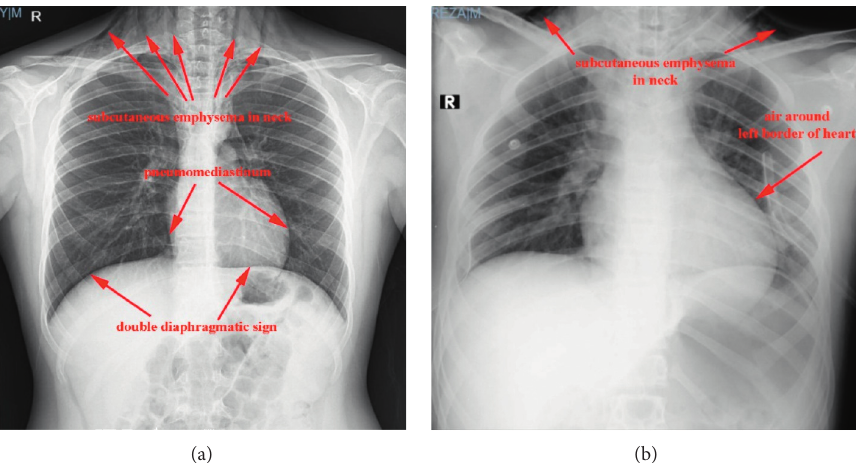
Figure 1: Chest X-ray revealing double diaphragmatic sign, air around the left border of the heart, and subcutaneous emphysema in the neck associated with pneumomediastinum.